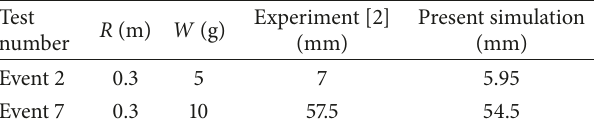
Figure 3: Three-dimensional model of the problem in [2] recon- structed in AUTODYN, a caption of pressure distribution as the shock front touches the shell. Table 6: Results of experiment [2] and present hydrocode simula- tion. Central permanent